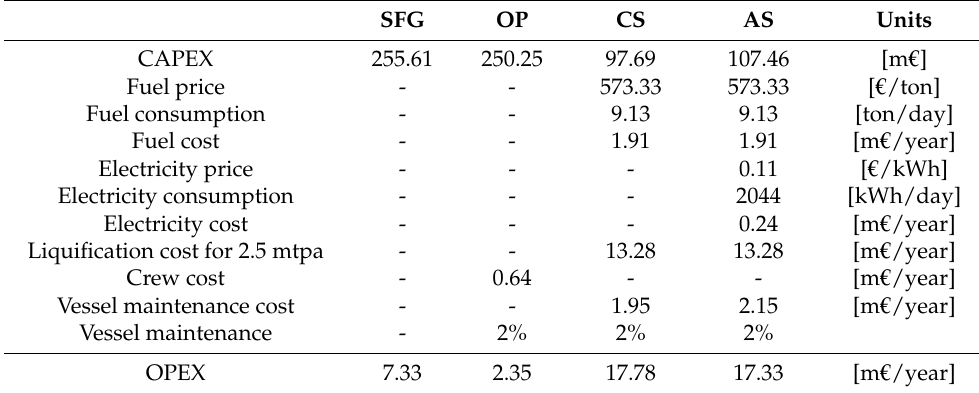
Table A9. OPEX average value results.